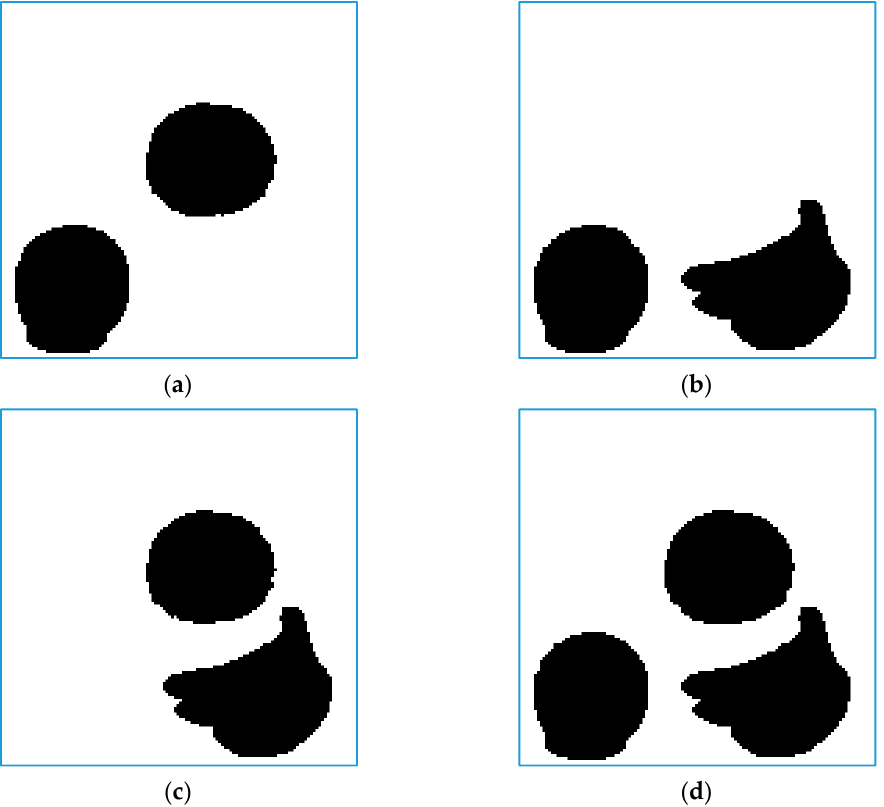
Figure 9. Detectability comparisons between [25–27] and the proposed method. ( a ) Detection result of [25]; ( b ) Detection result of [26]; ( c ) Detection result of [27]; ( d ) Detection result of the proposed method.